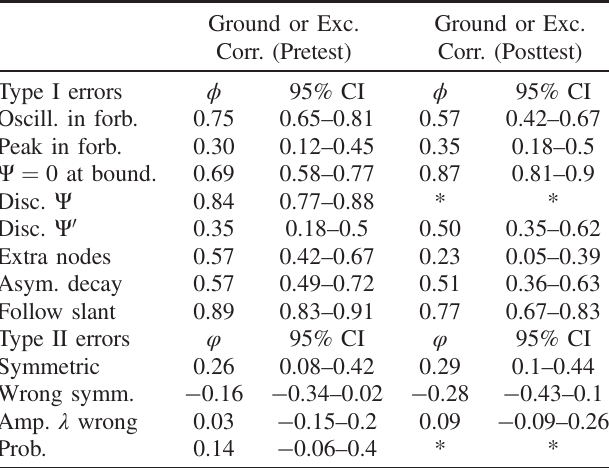
TABLE IV. Correlations ( φ coefficients) between common student errors on the ground state and 2nd excited state. Type I errors are those that are equally applicable to the ground and 2nd excited states, while type II errors are those that would be impossible to make or identify in the ground state, unless additional errors were